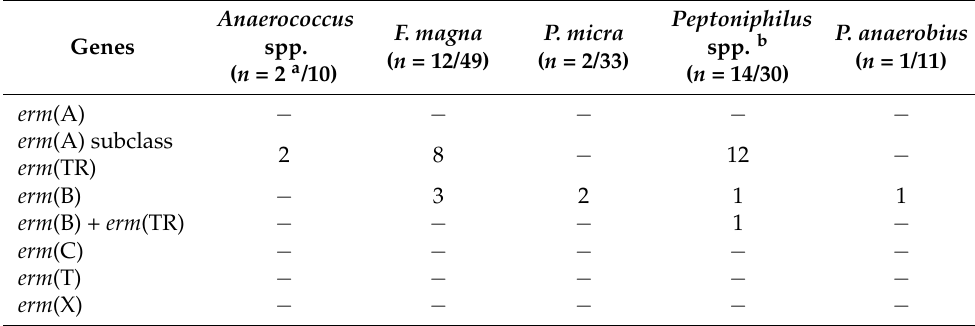
Table 2. Acquired genes of macrolides-lincosamides-streptogramins (MLS) resistance among the 31 clindamycin resistant GPAC clinical isolates. Anaerococcus F. magna P. micra spp. b Genes spp. ( n = 12/49) ( n = 2/33) ( n = ( n = 2 a /10) ( n = 14/30)